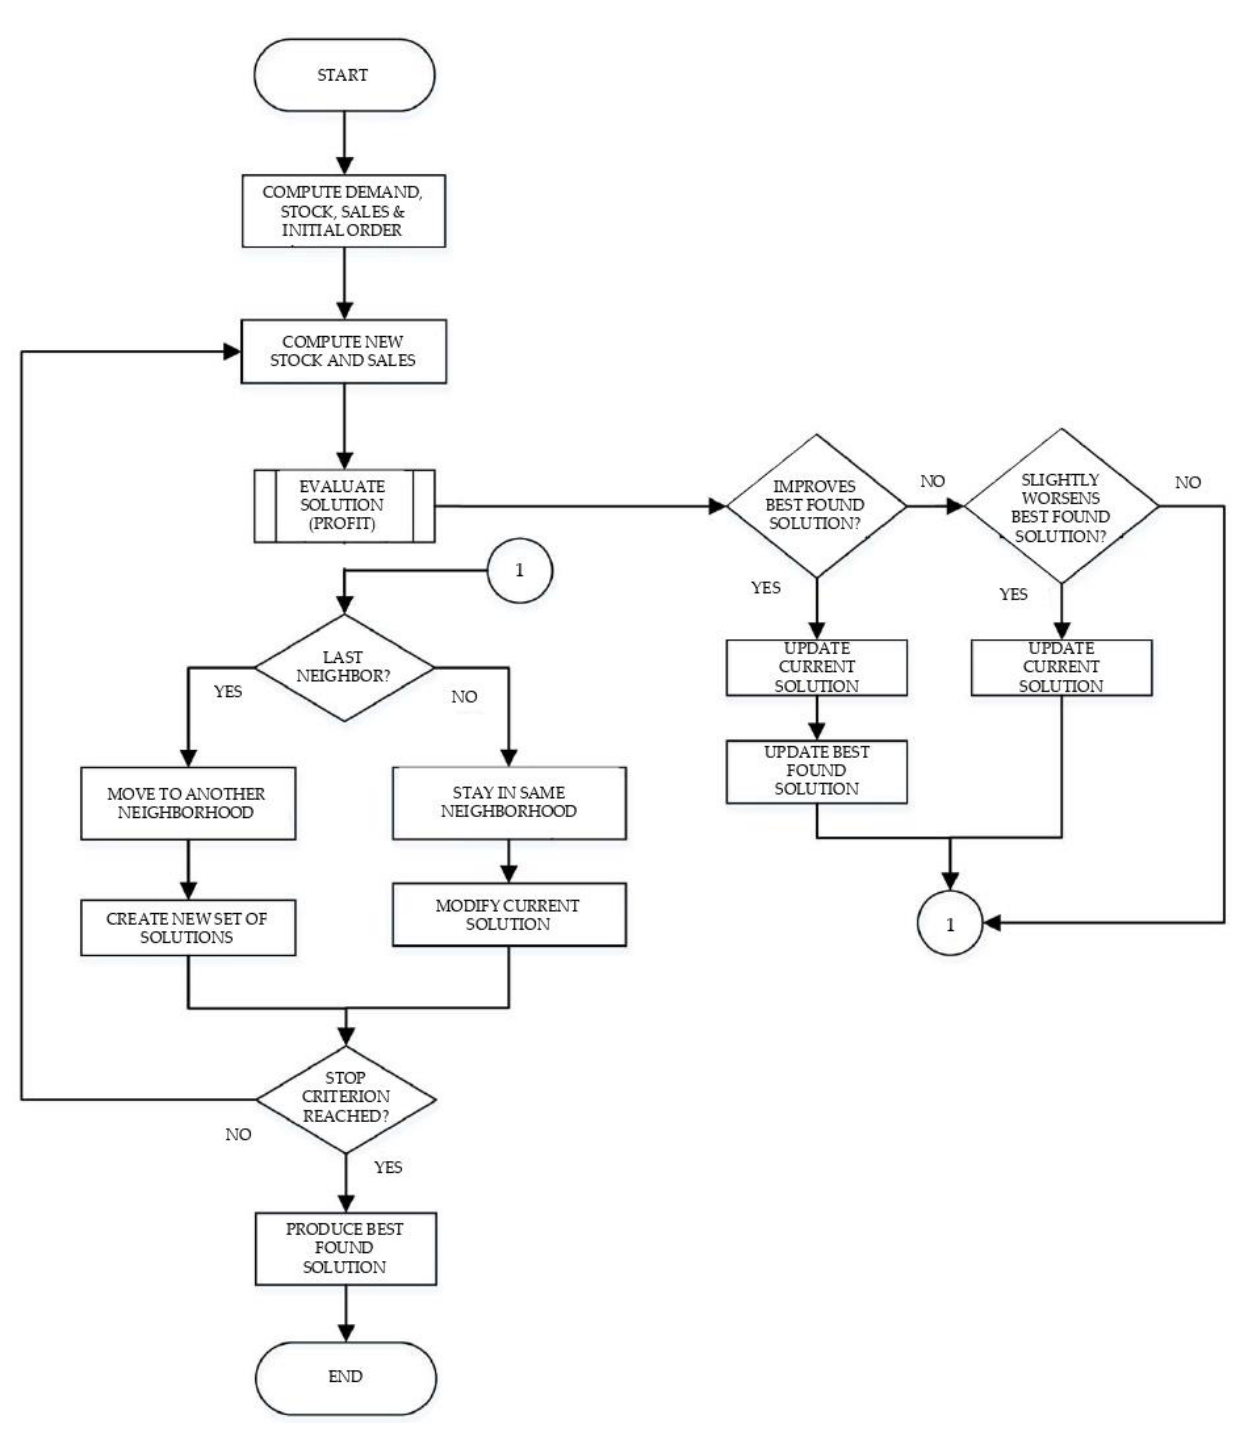
Figure 1. Flowchart of the meta-heuristic.